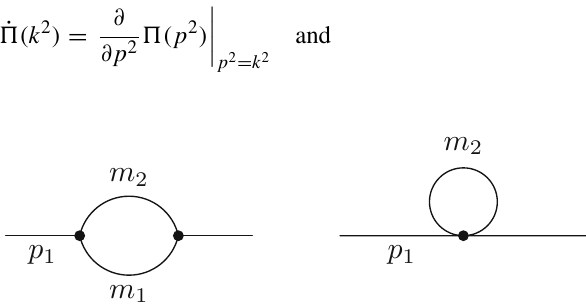
Fig. 2 Possible topologies contributing to the wave-function renor-